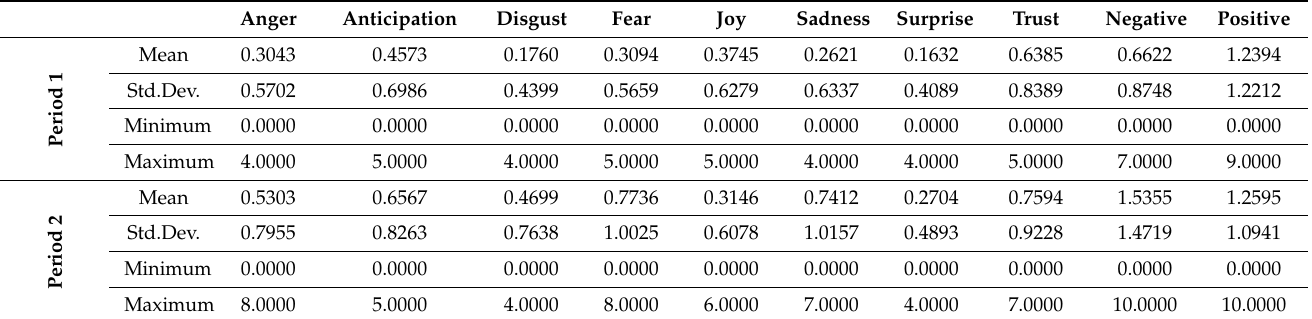
Table 2. Summary statistics of sentiments and